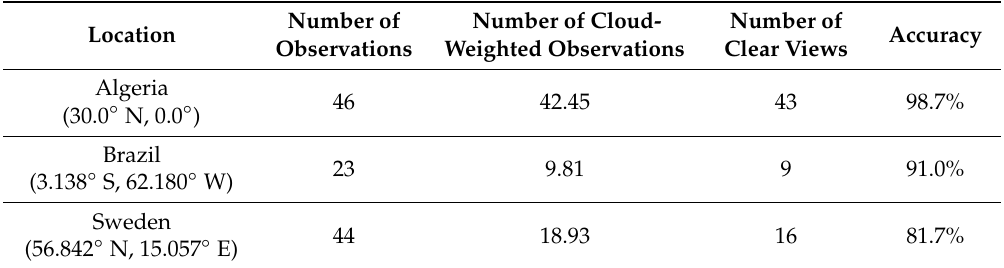
Table 2. Number of observations, number of cloud-weighted observations, number of clear views and the accuracy of Landsat-8 acquisition imageries covering the three selected locations in the year 2018.